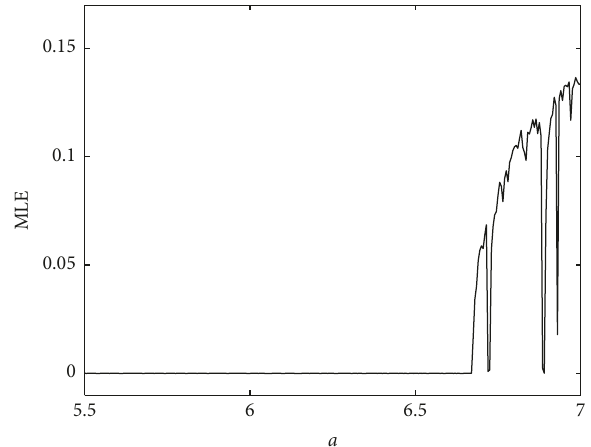
Figure 2: Presentation of maximum Lyapunov exponents for 𝑎 ∈ [5.5,7] , while 𝑏 = 4 and 𝑐 = 1